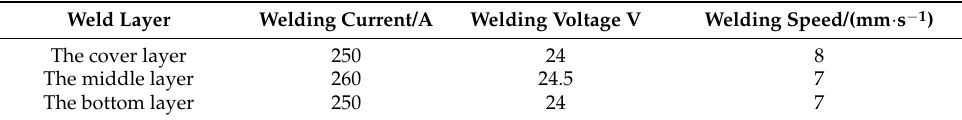
Figure 2. Cross-sectional morphologies of the two welded joints. ( a ) ER5356 welded joint, ( b ) ER5087 welded joint. Table 2. MIG welding parameters of 7N01-T4 aluminum alloy.